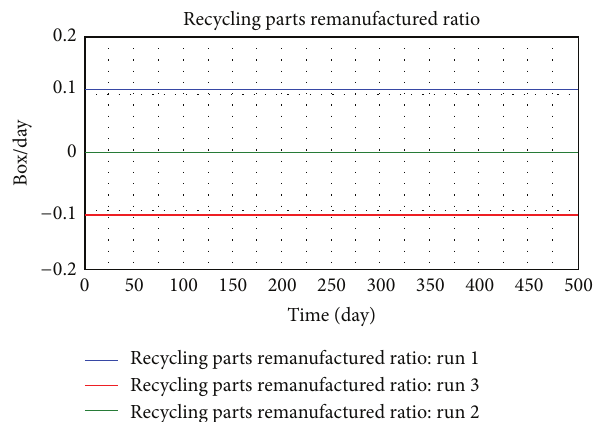
Figure 5: Parts recycling ratio under different recycler reaction coefficients.